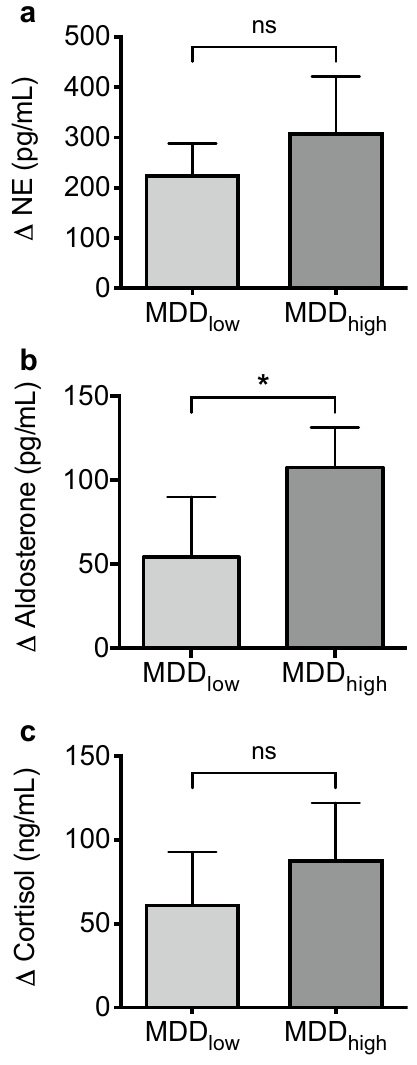
Figure 2. Fasting results in similar increases in stress parameters in MDDlow and MDDhigh. Bar graphs (mean with SEM) depict delta values showing the difference post- to pre-fasting (T2–T1) of norepinephrine (NE, a ), aldosterone ( b ), and cortisol ( c ) in MDDlow (BDI ≤ 19 at T1) and MDDhigh (BDI > 19 at T1). Mann–Whitney test was used to calculate two-tailed P -values. * P < .05. MDDlow: N = 11, MDDhigh: N =